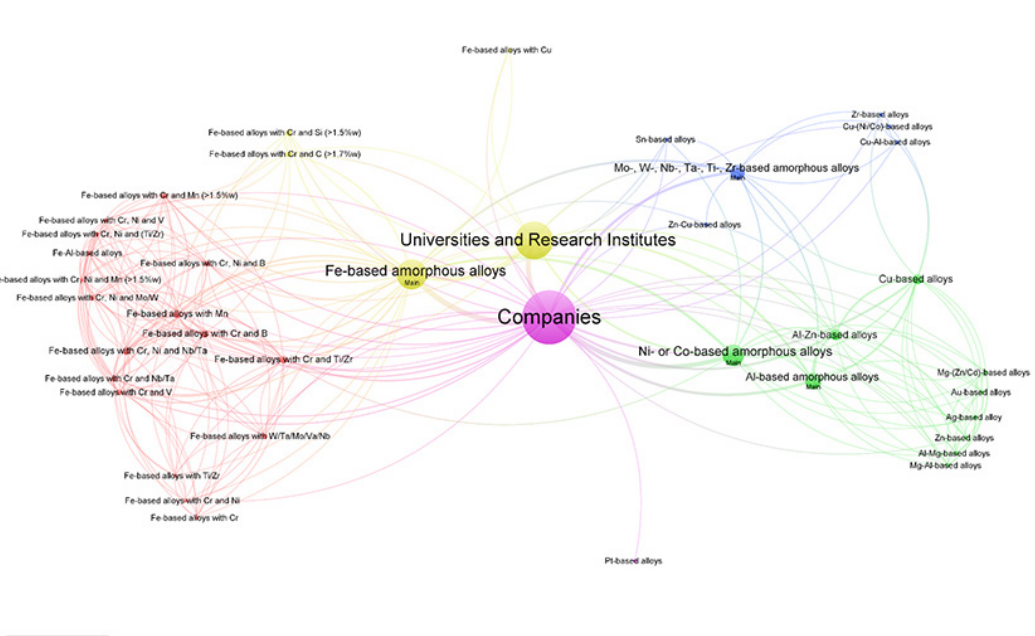
Figure 6. Companies and Universities or Research Institutes patent networking according to the main amorphous/glassy metals and their details. The nodes indicated an alloy or a type of assignee, the size of the node is proportional to the total of patent documents of it, and the lines indicates the total number of patents the nodes share; they were colored according to a